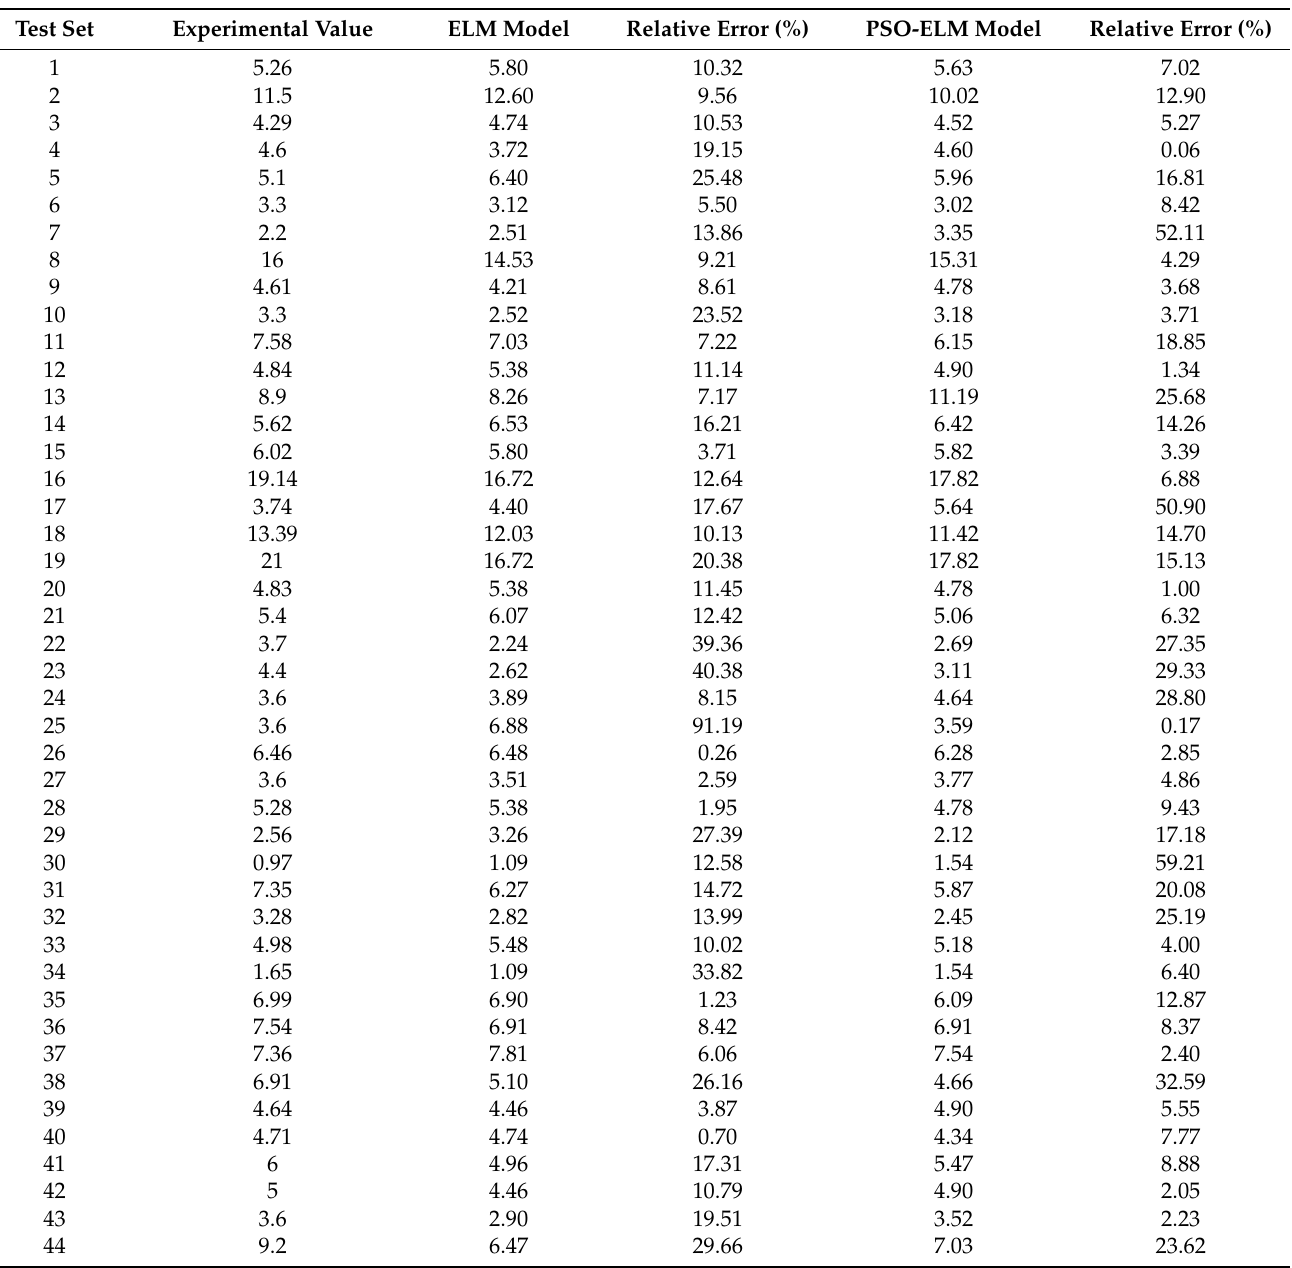
Table 2. Model prediction results and relative errors of the test set.